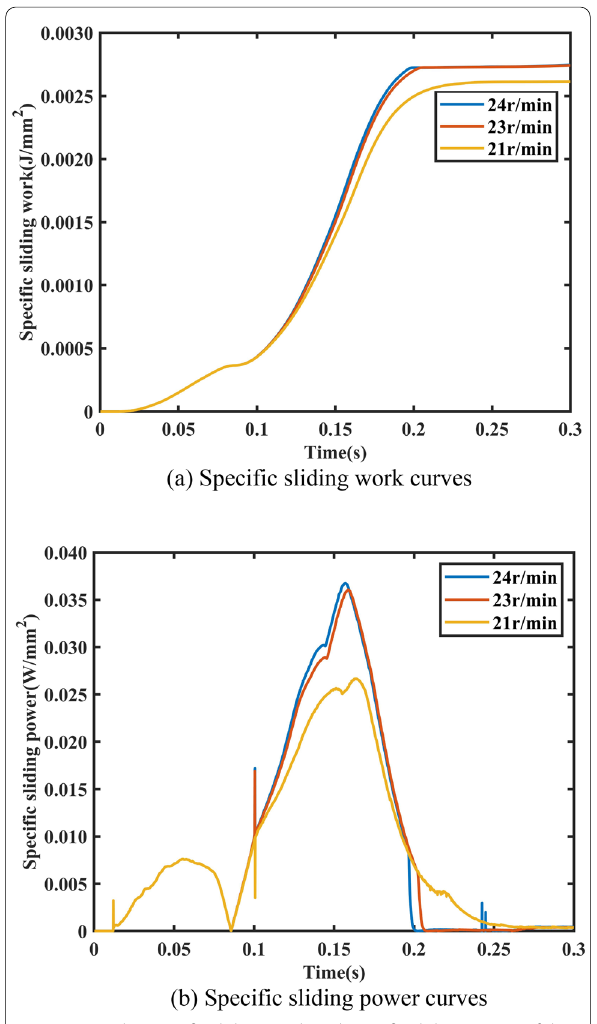
Figure 21 The specific sliding work and specific sliding power of the PCFRS under different shifting speeds